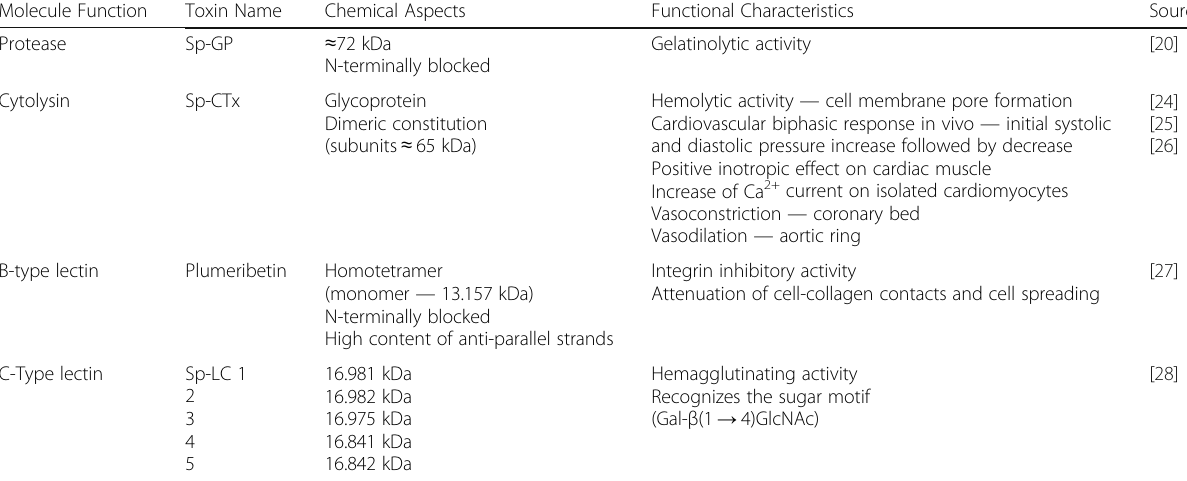
Table 1 Toxins purified from SpV to